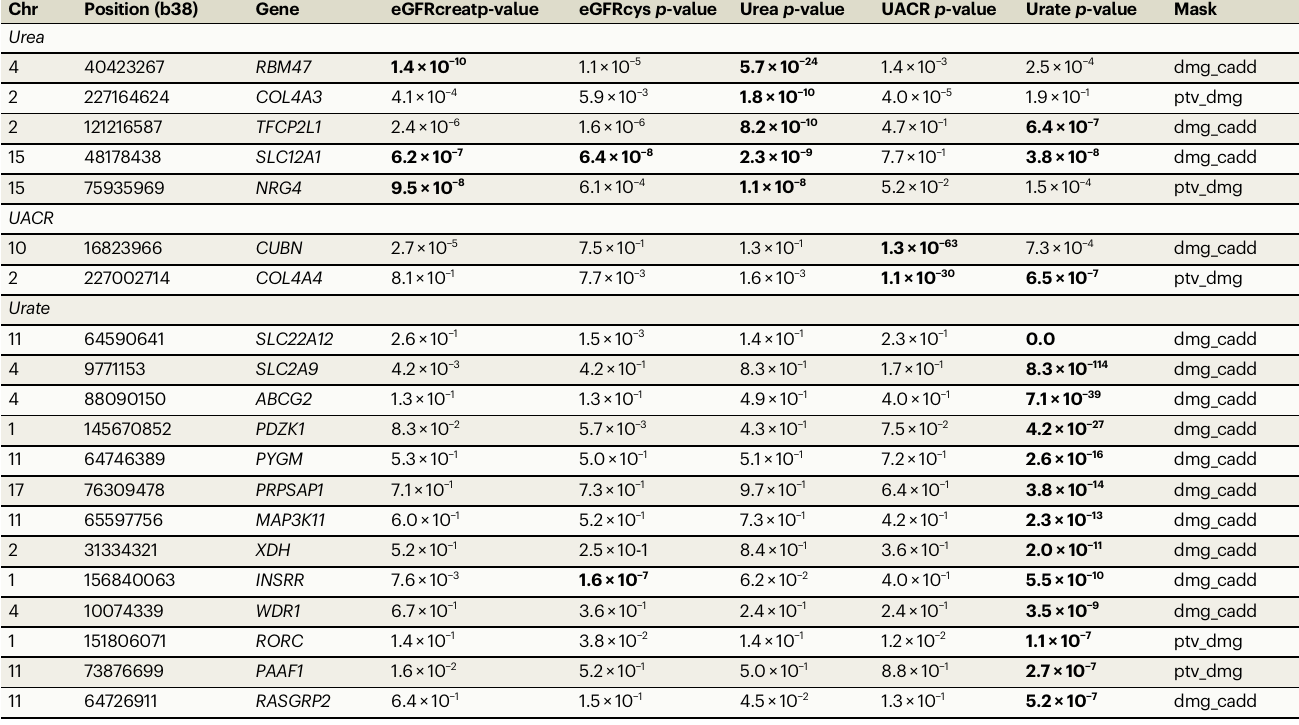
Table 3 | Overview of gene-based test results for Urea, UACR, and Urate Chr Position (b38)